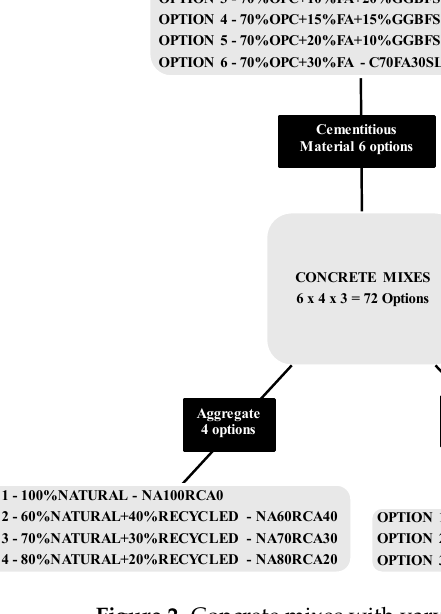
Figure 2. Concrete mixes with varying % of substitutions.